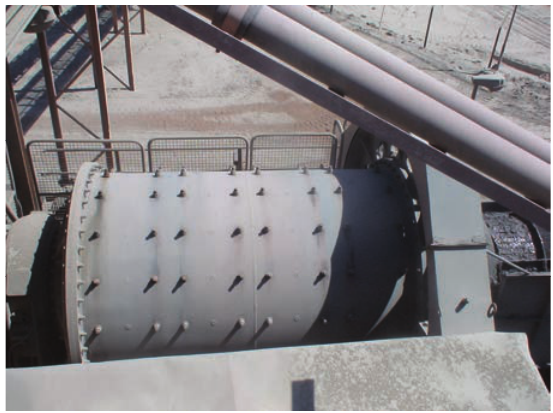
Figure 4. Photograph shows the ball mill.